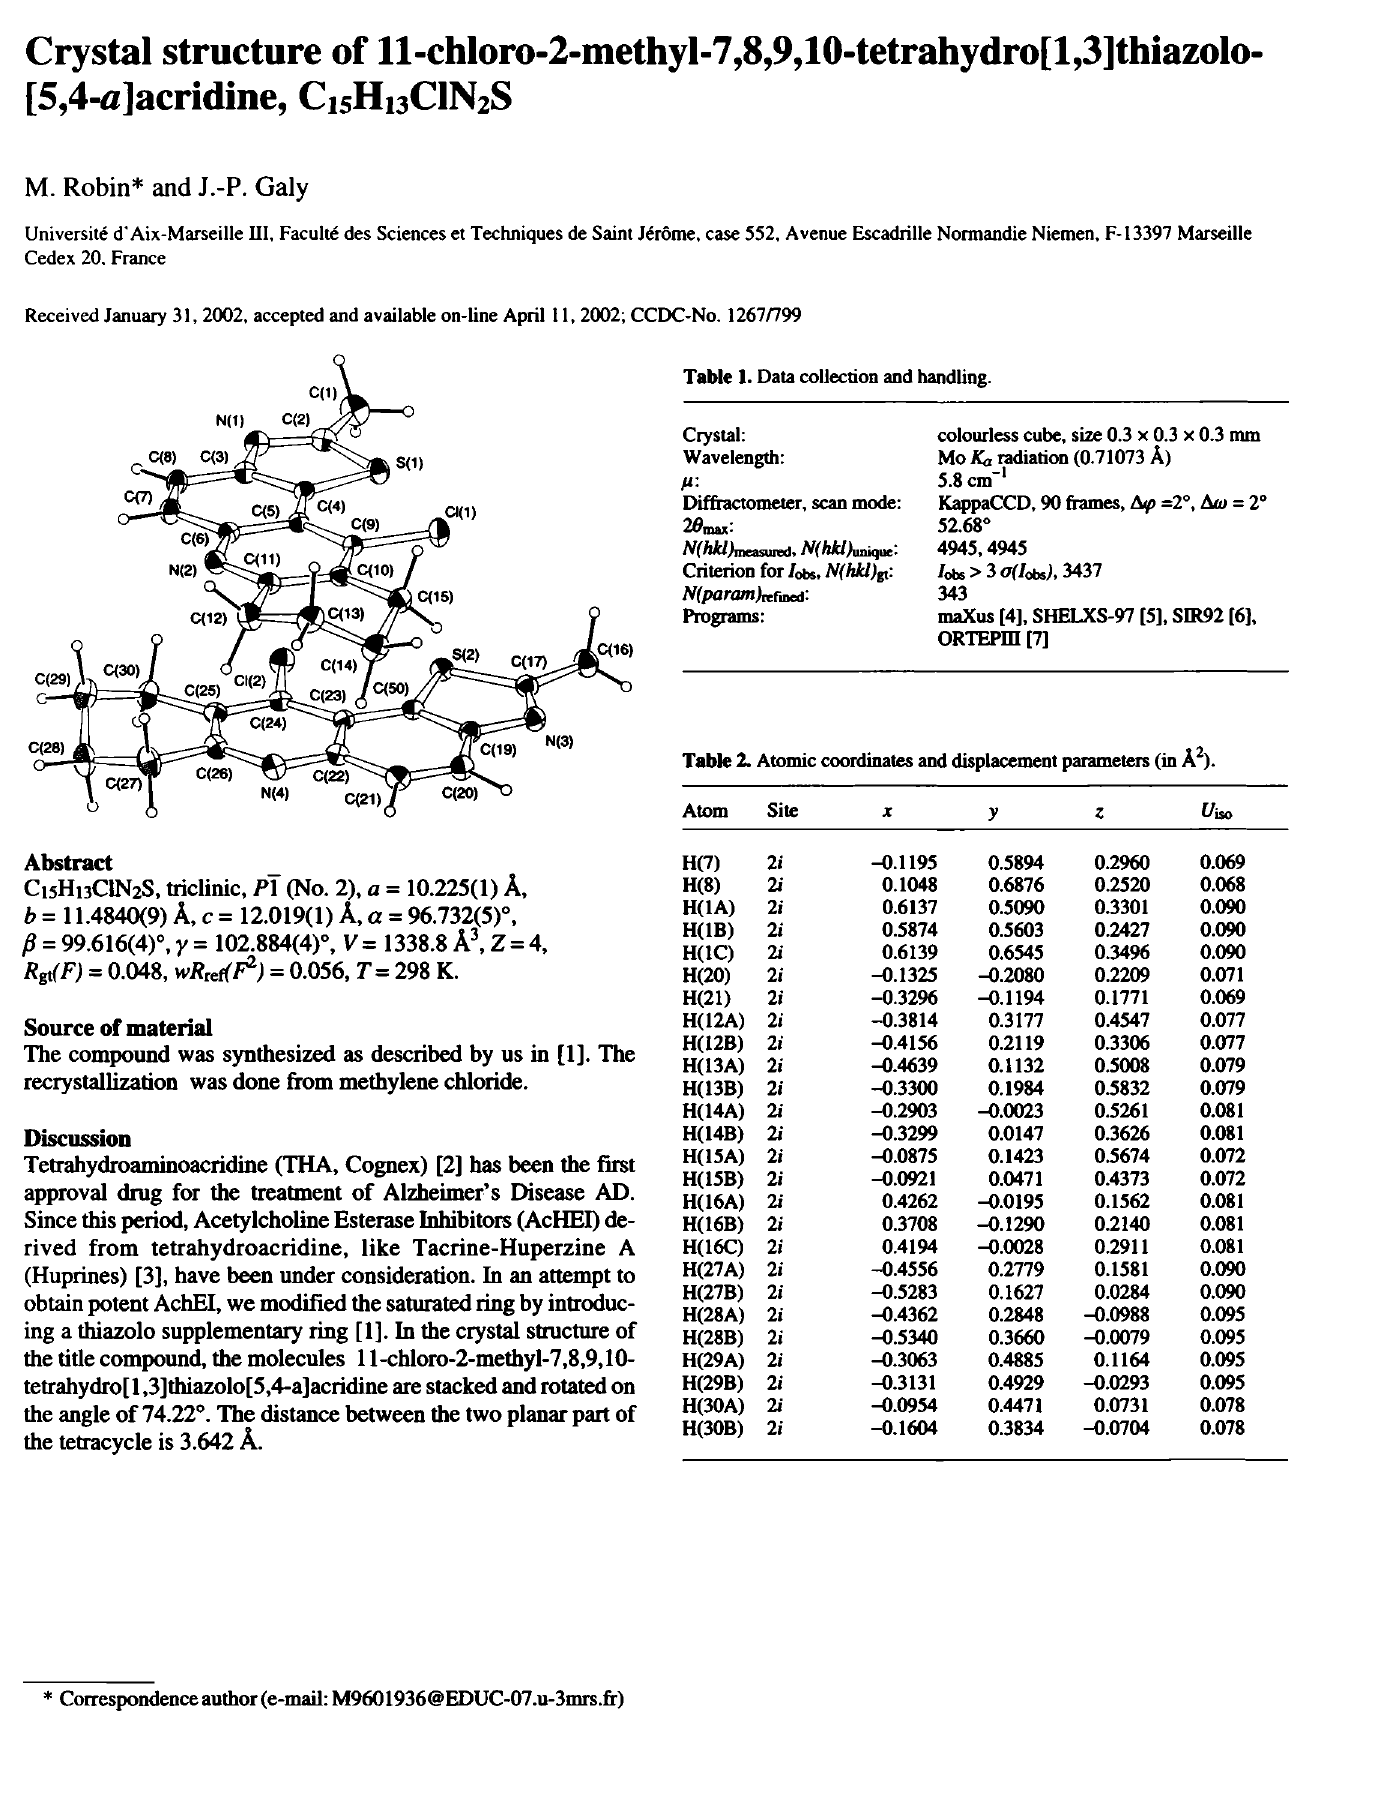
Table 2. Atomic coordinates and displacement parameters (in Â 2